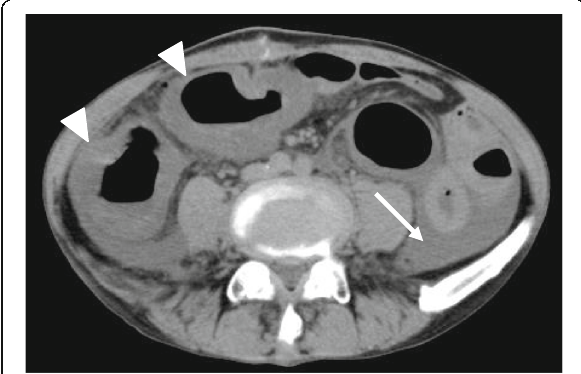
Fig. 4 In CT on the 7th postoperative day, ascites (white arrow), colon dilation and colonic wall thickening (white triangle) was evident